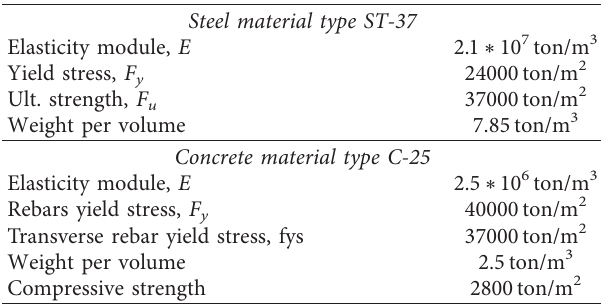
Table 5: Specifications of steel and concrete materials